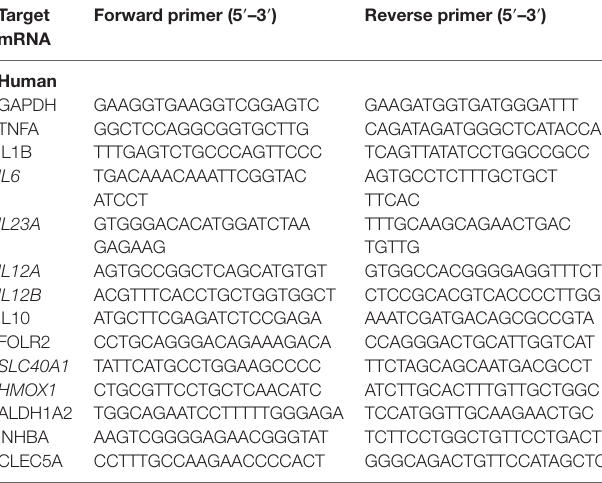
Table 1 | Primers used in this